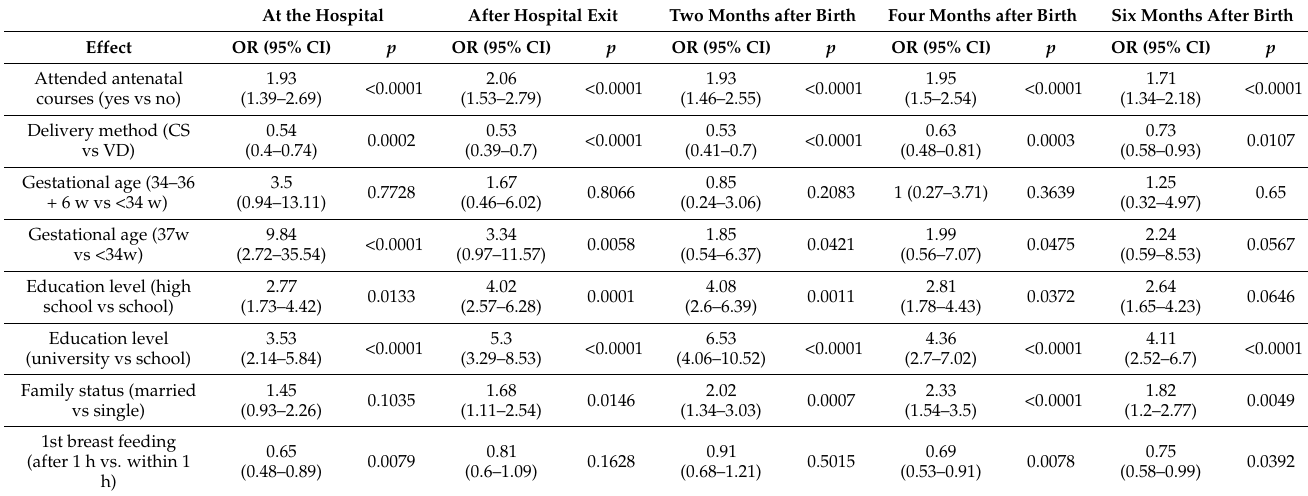
Table 7. Multivariate analysis about the indicators of the exclusive breastfeeding by infants’